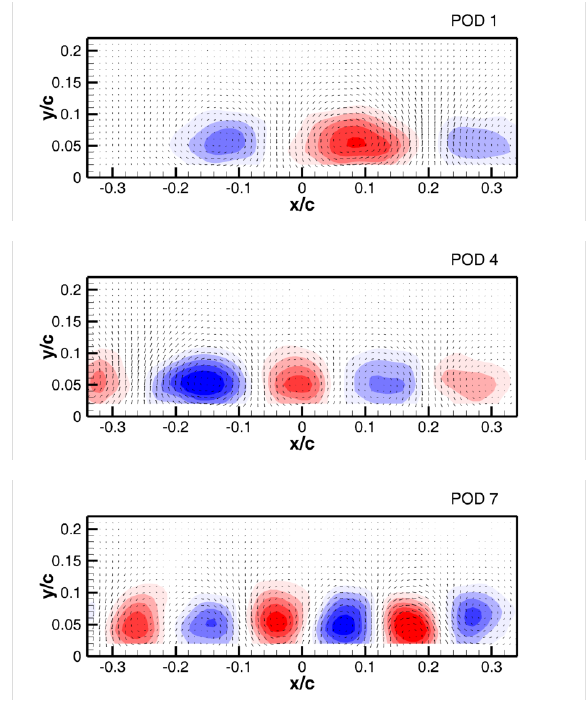
Fig. 7. POD modes 1, 4 and 7 of vector-field dynamics, measuring plane